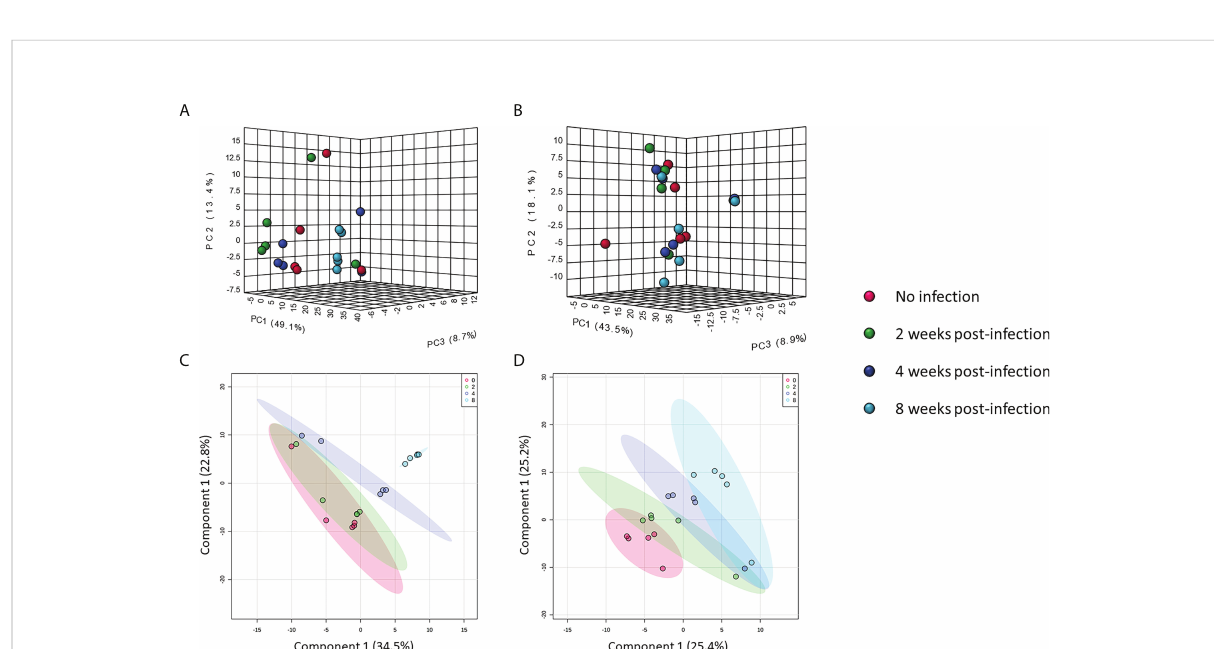
FIGURE 2 Multivariate analysis of metabolomic data. Interactive 3D-PCA of features in positive mode (A) and negative mode (B) . PLS-DA of features in positive mode (C) and negative mode (D) .